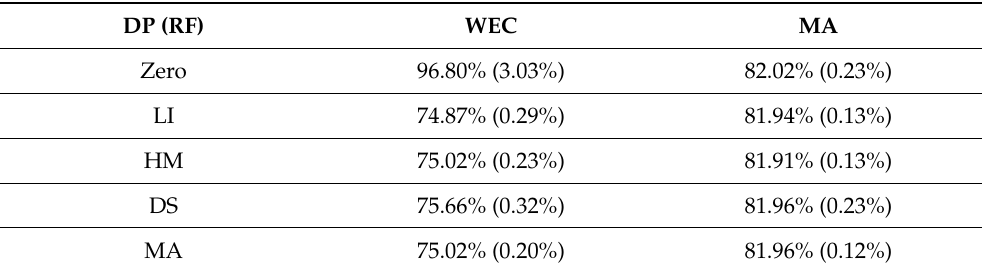
Table 3. Average detection performance depending on imputation methods. DP